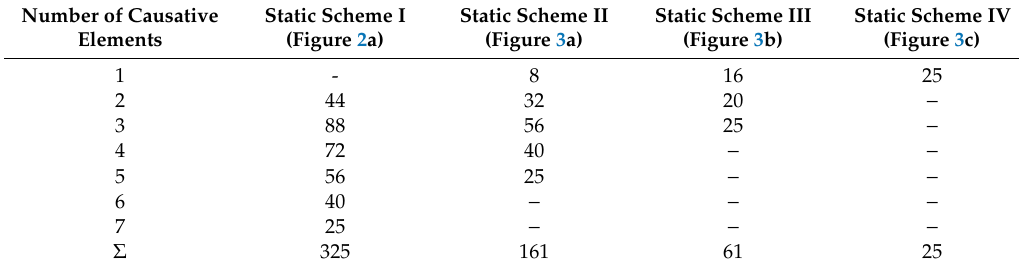
Table 1. Kinematically admissible failure mechanisms for truss “0” [26].